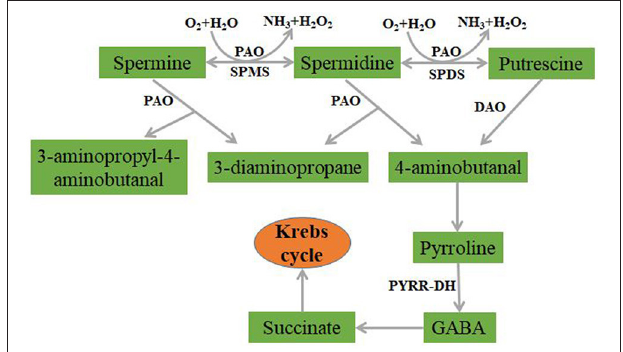
FIGURE 2 | The pathway of polyamine catabolism in